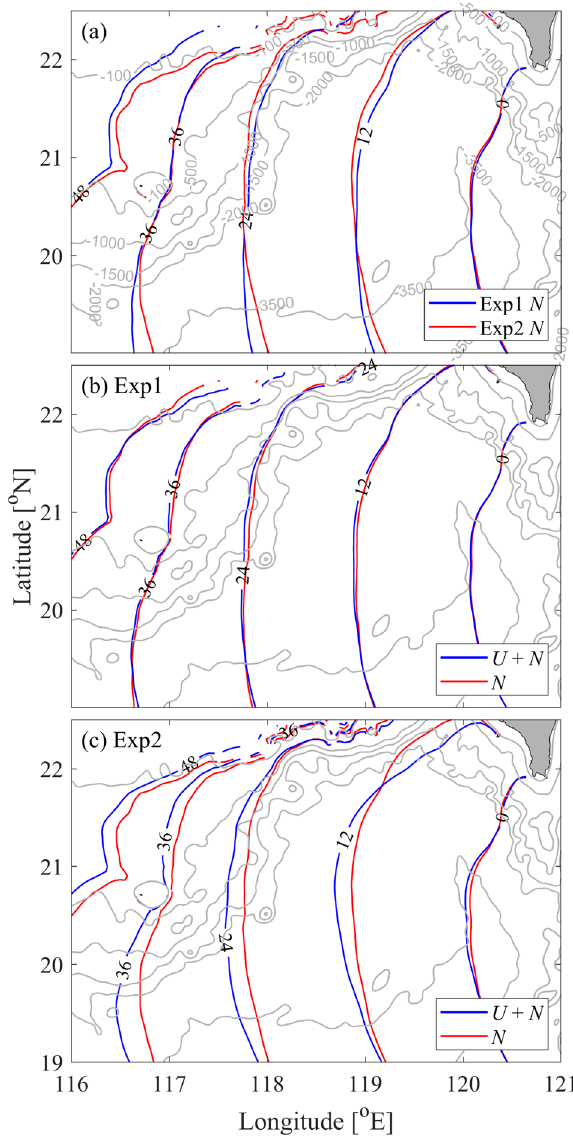
Figure 10. ( a ) The predicted wavefronts without considering the background current. ( b,c ) Comparison of wavefronts calculated by considering only N and both U and N for Exp1 and